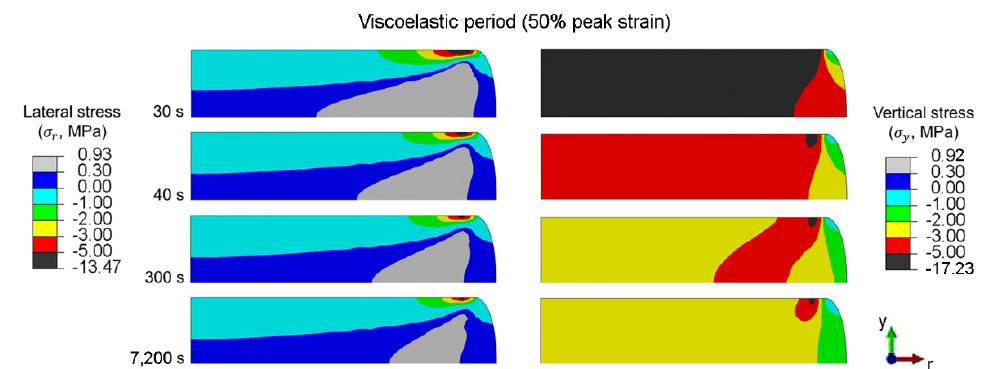
Figure 14. Distributions in the lateral and vertical stresses of disc-A during the viscoelastic period (50% peak strain).